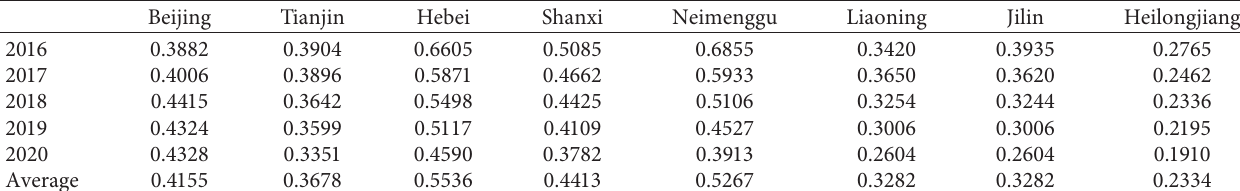
Table 1: Performance evaluation values of the national average workers’ basic pension insurance system.